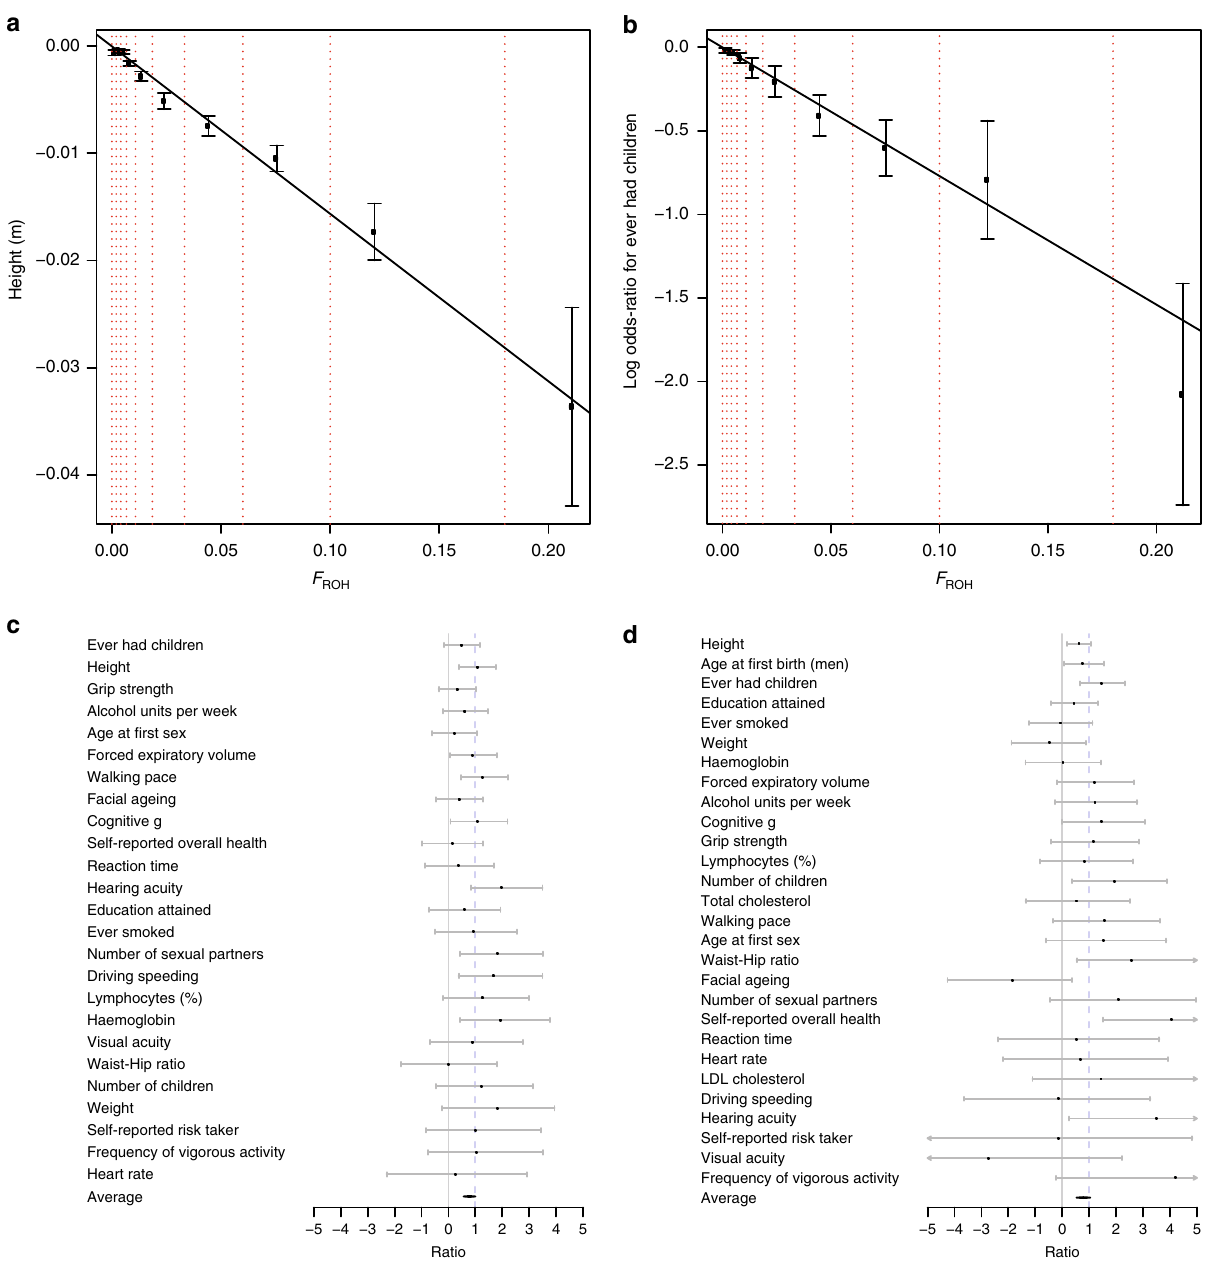
Fig. 5 Evidence ROH effects are un-confounded. a Linear decrease in height with increasing F ROH . Average heights (in metres) is plotted in bins of increasing F ROH . The limits of each bin are shown by red dotted lines, and correspond to the offspring of increasing degree unions left-to-right. The overall is shown as a solid black line. Subjects with kinship equal to offspring of full-sibling or parent – child unions are signi fi cantly shorter than estimate of β F ROH those of avuncular or half-sibling unions who in turn are signi fi cantly shorter than those of fi rst-cousin unions. b Linear decrease in odds of ever having children with increasing F ROH . Linear model approximations of ln(Odds-Ratio) for ever having children (1 = parous, 0 = childless) are plotted in bins of increasing F ROH . A strong relationship is evident, extending beyond the offspring of fi rst cousins. c ROH effects are consistent in adoptees. The ratios of effect estimates, β F , between adoptees and all individuals are presented by trait. All traits are directionally consistent and overall show a strongly ROH signi fi cant difference from zero (average = 0.78, 95% CI 0.56 – 1.00, p = 2 × 10 − 12 ). FEV1 forced expiratory volume in one second. d ROH effects are consistent in full siblings. The ratios of effect estimates within full siblings to effects in all individuals ( β F of 29 estimates are directionally consistent and overall show a signi fi cant difference from zero (average = 0.78, 95% CI 0.53 – 1.04, p = 7 × 10 − 10 ). BMI body mass index. All errors bars represent 95% con fi dence